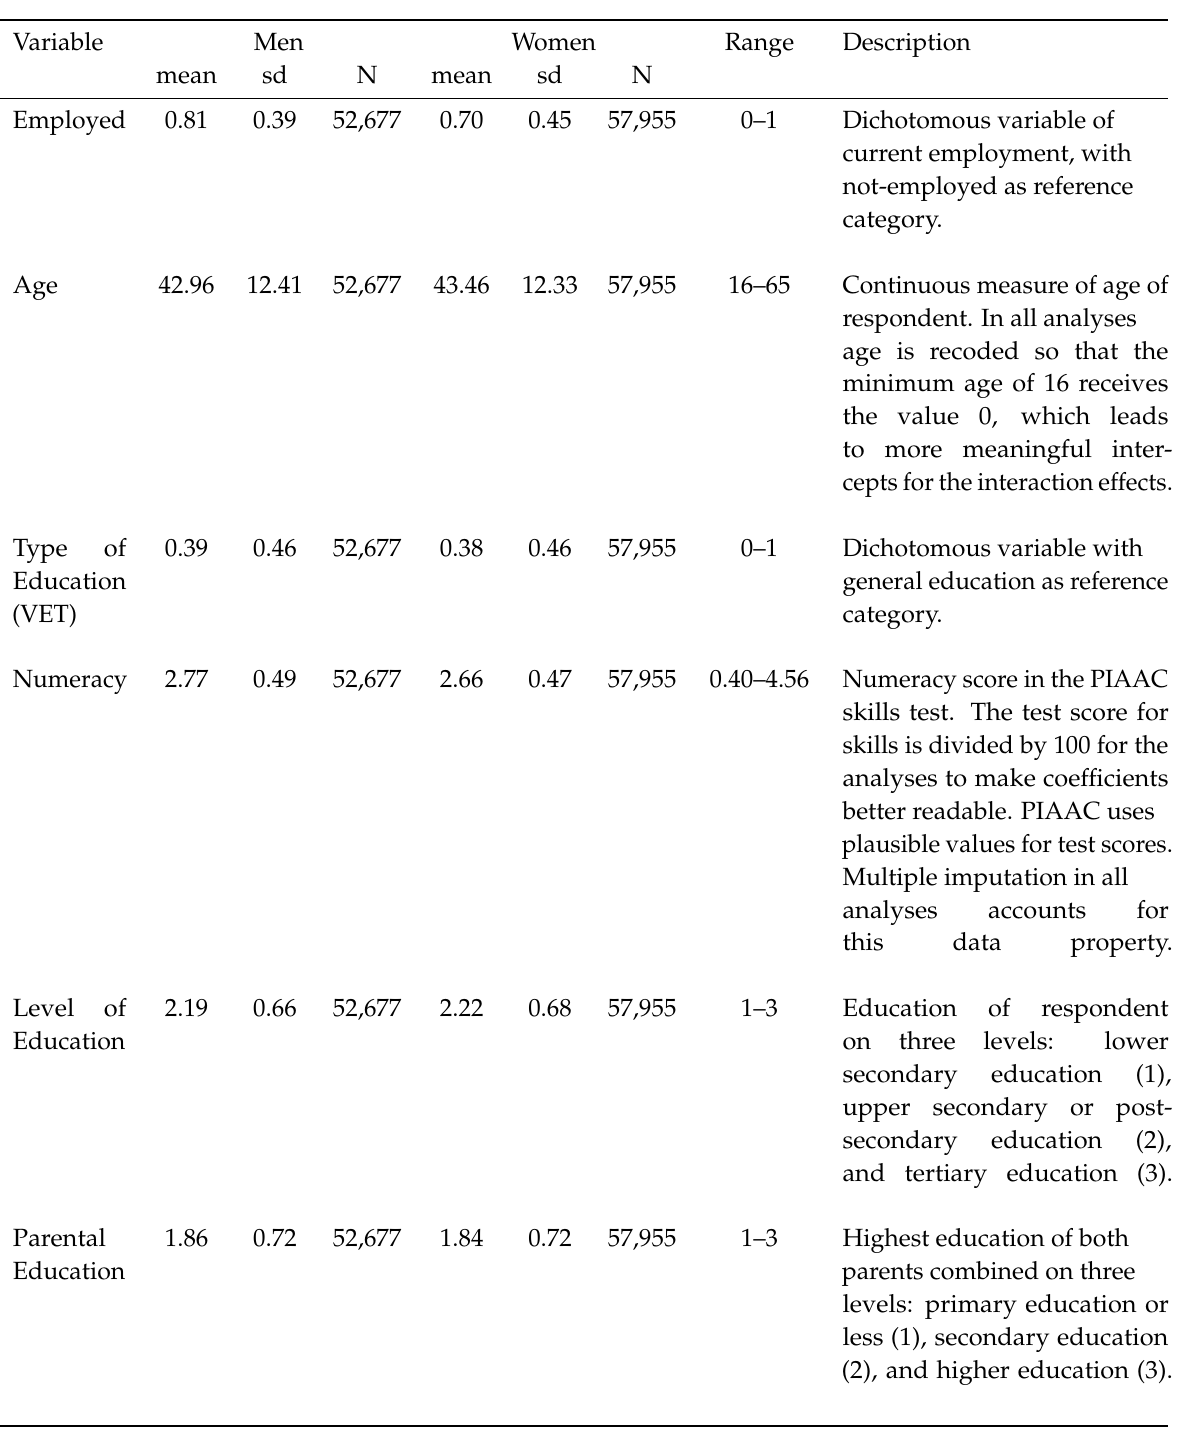
Table 1: Summary Statistics and Coding of Variables